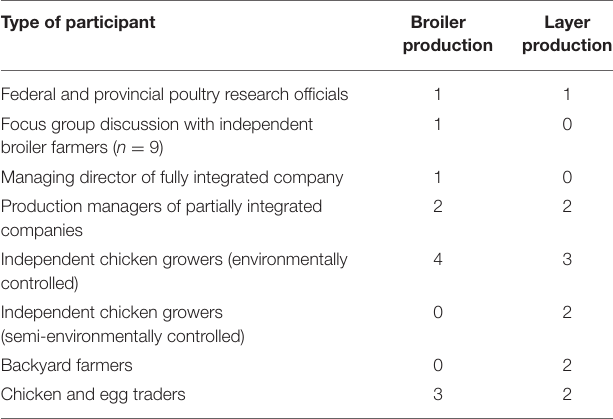
TABLE 1 | Type and number of participants